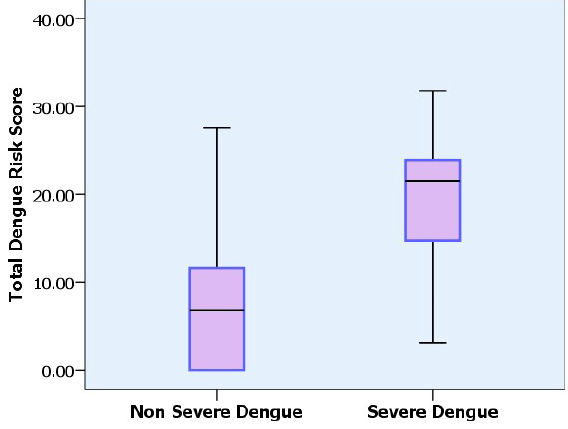
Figure 3. The average dengue risk scores between the groups of non-severe dengue infection and Figure 3 . The average dengue risk scores between the groups of non - severe dengue infection and severe dengue severe dengue infection .